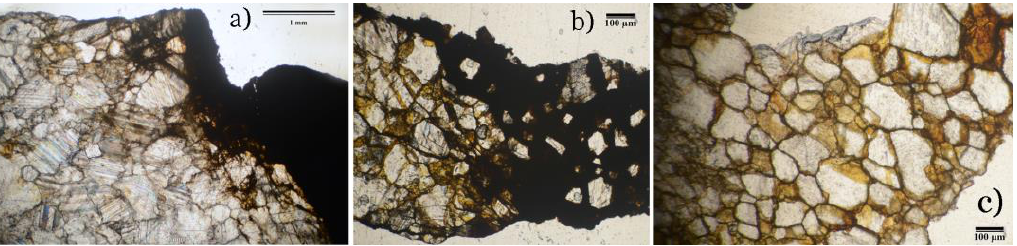
Figure 2. Thin NS1 ( a ), NS3 ( b ), and NS8 ( c ) sections that show the infiltration of iron phases inside the carbonate matrix. OM polarized light analysis, 25×.